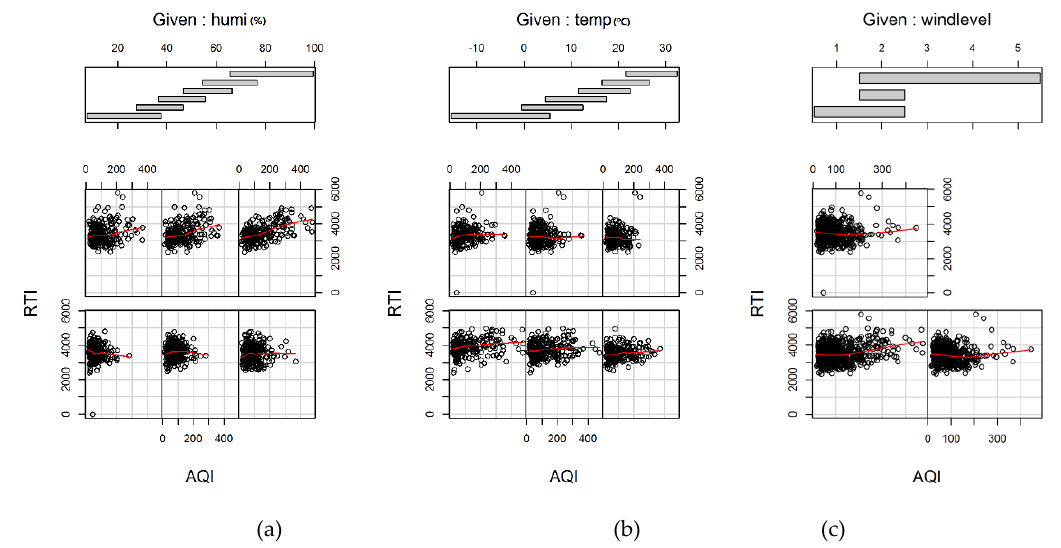
Figure 6. Coplot showing the relationship between the variables air quality index (AQI) and RTI conditioned on meteorological factors (humidity, temperature, and wind level): ( a ) the relationship between RTI and AQI conditioned on humidity; ( b ) the relationship between RTI and AQI conditioned on temperature; and ( c ) the relationship between RTI and AQI conditioned on wind speed.